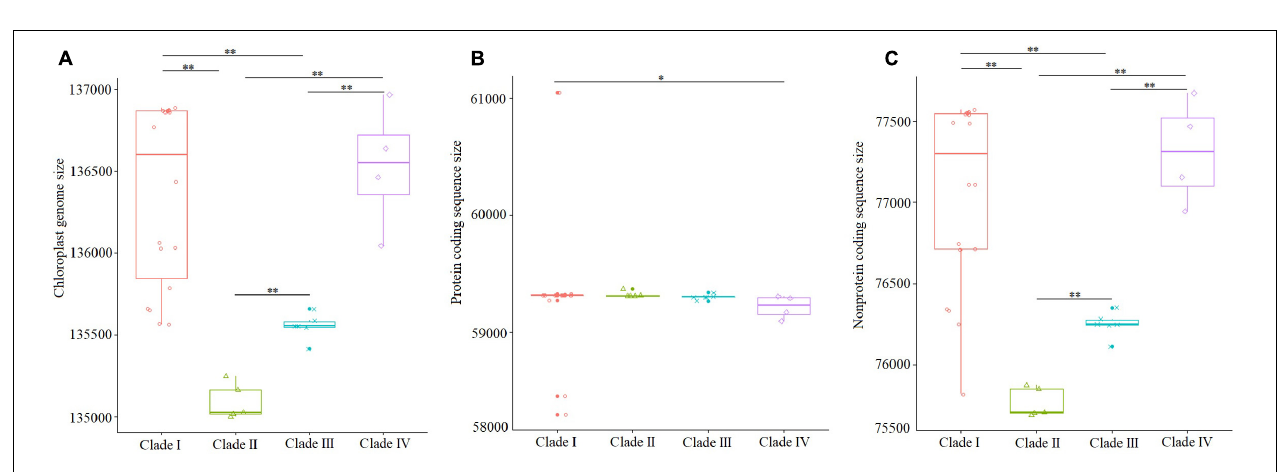
FIGURE 5 | Correlation tests of number of indel in 34 chloroplast genomes of Triticeae species against divergence time and chloroplast genomes size. (A) A correlation test of number of indel against divergence time ( R = 0.87, p = 1.6e-10 < 0.05). (B) A correlation test of number of indel against chloroplast genomes size ( R = 0.37, p = 0.04).